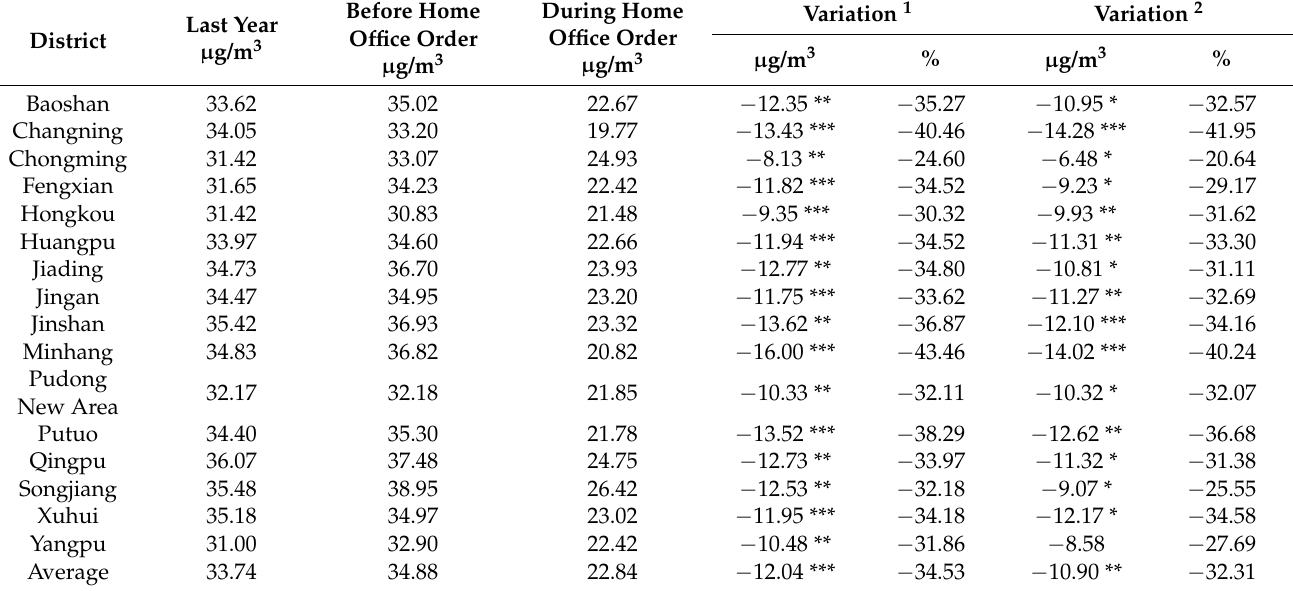
Table 2. Variation of daily PM 2.5 concentrations after implementing the home office order for 60 days.